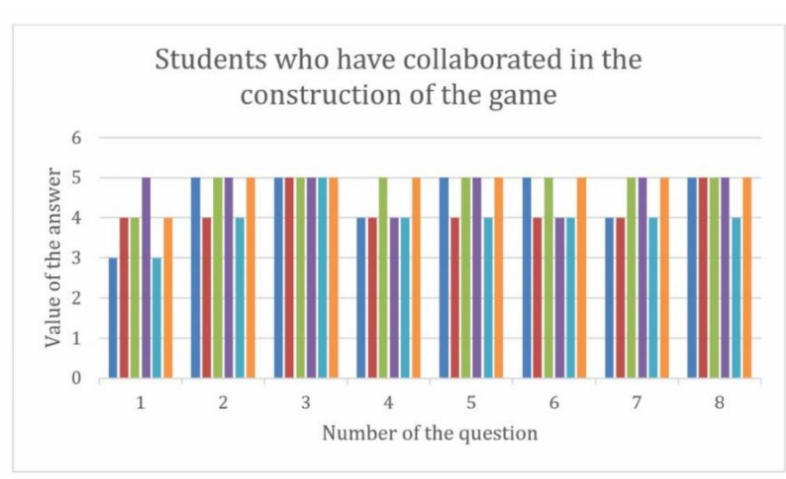
Figure A1. Results of the survey of the students who collaborated in the making of the